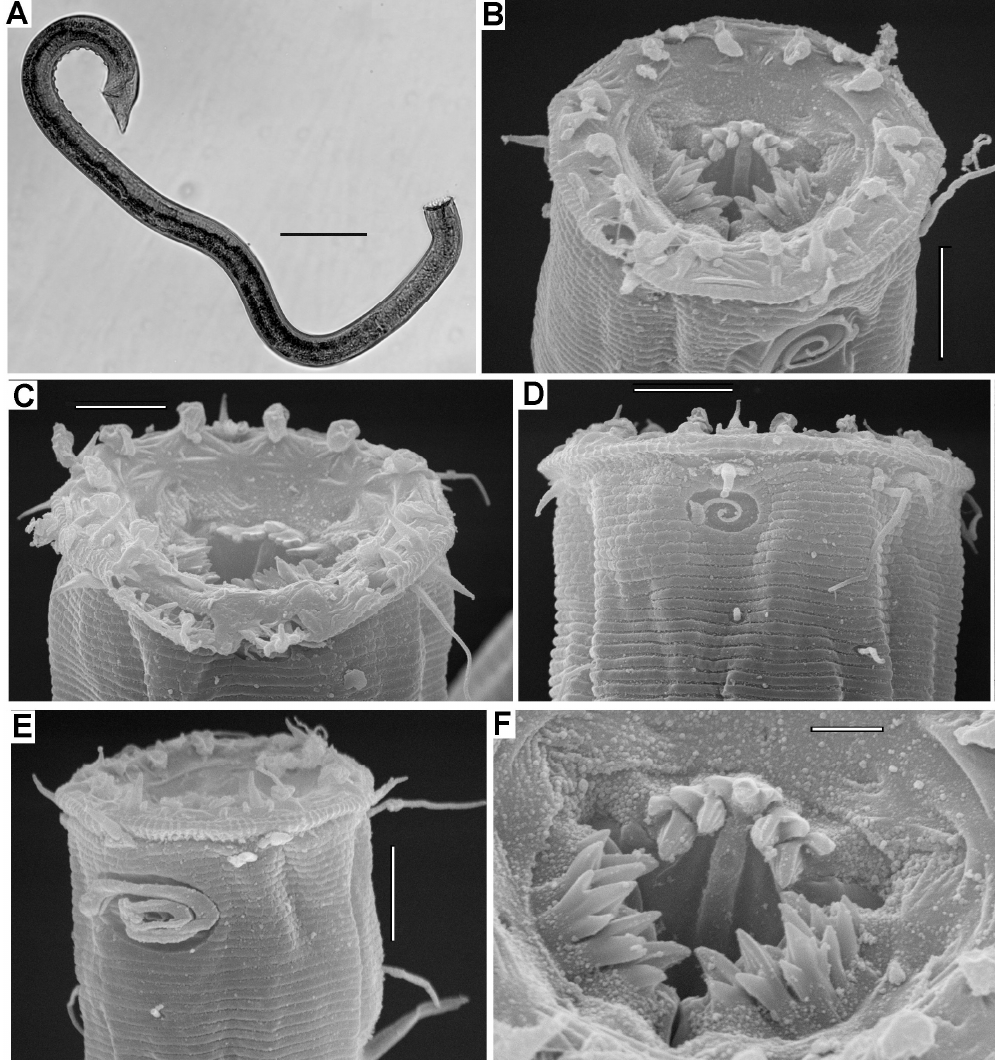
Figure 4. Gammanema okhlopkovi sp.n., entire view and anterior body: ( A ) holotype, male, entire view; ( B ) apical view, male, scanning electron micrograph; ( C ) subapical view, female, scanning electron micrograph; ( D ) head, lateral view, female, scanning electron micrograph; ( E ) head, sublateral view, male, scanning electron micrograph; ( F ) mouth opening, male, scanning electron micrograph. Scale bars: ( A ) 100 μ m, ( B ) 10 μ m, ( C ) 10 μ m, ( D ) 10 μ m, ( E ) 10 μ m, ( F ) 3 μ m.